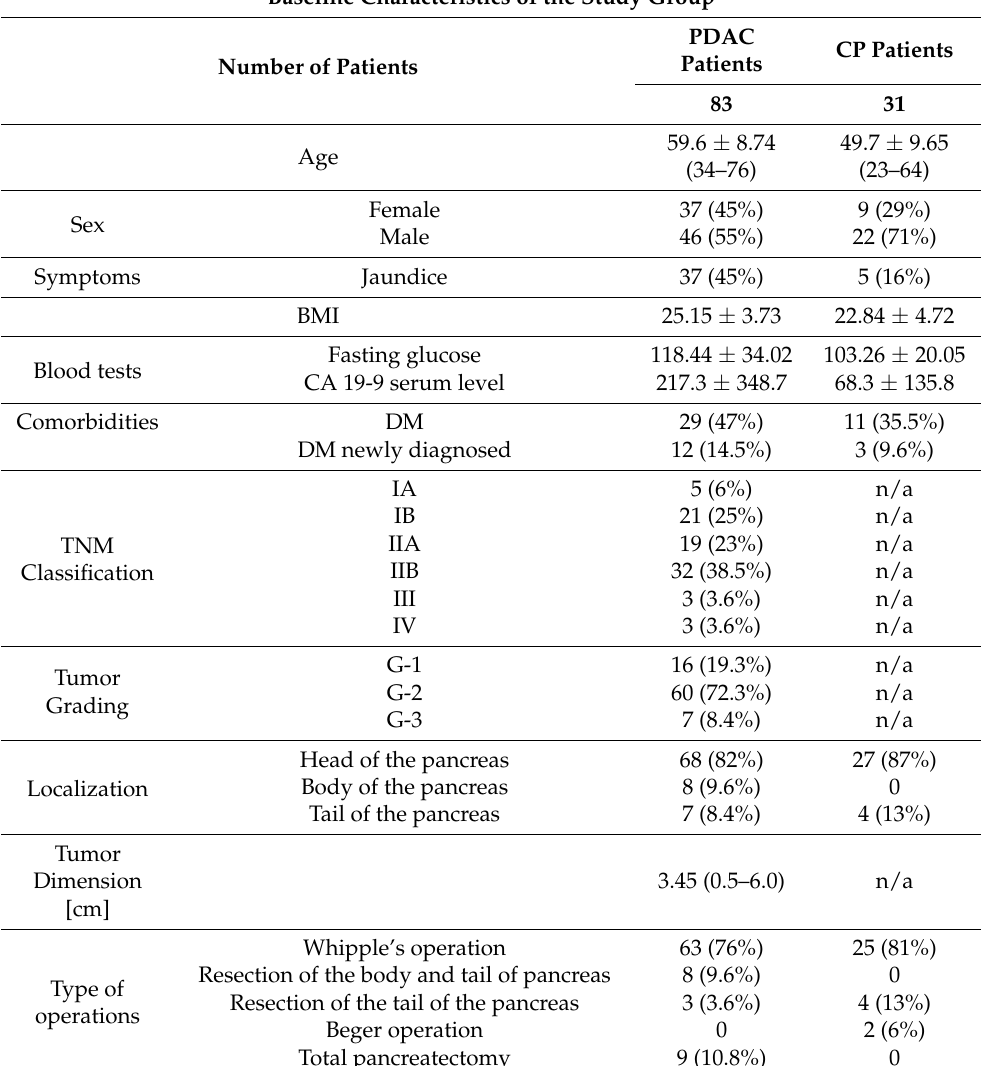
Table 1. Baseline Characteristics of the Study